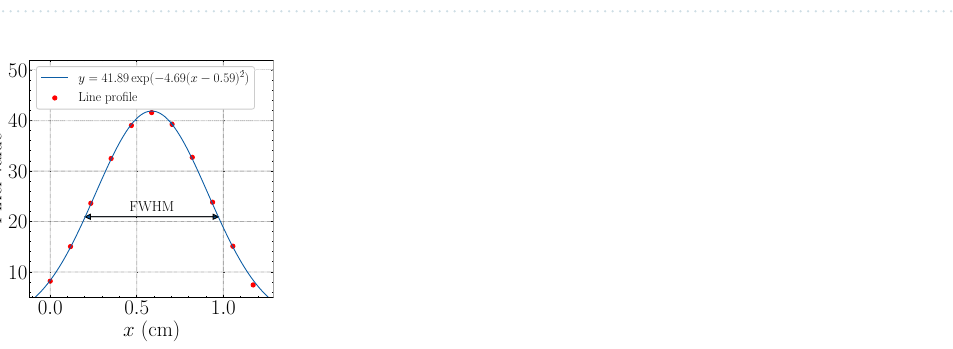
Figure 3. Image reconstruction and pin identification using the simple response matrix in Case 1.